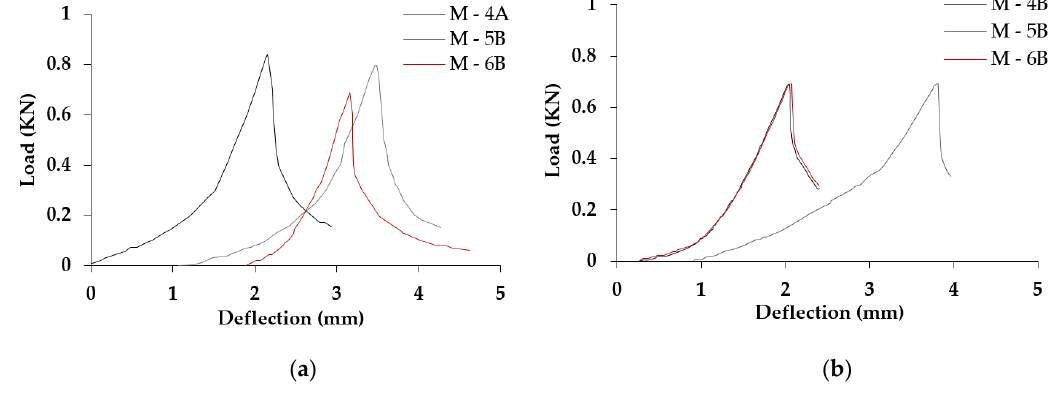
Figure 9. Load-deflection curves from bending tests. ( a ) recommended proportion; ( b ) double proportion.